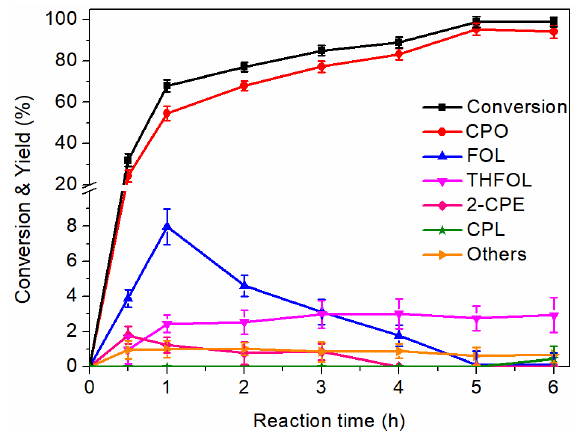
Figure 10. Variation of conversion and yield with reaction time in hydrogenative ring-rearrangement of FAL over Pd/UiO-66-NO 2 - 7 . Reaction conditions: catalyst (5.0 mg), FAL (100.0 mg), H 2 O (9.9 g), 150 ◦ C, 1.0 MPa H 2